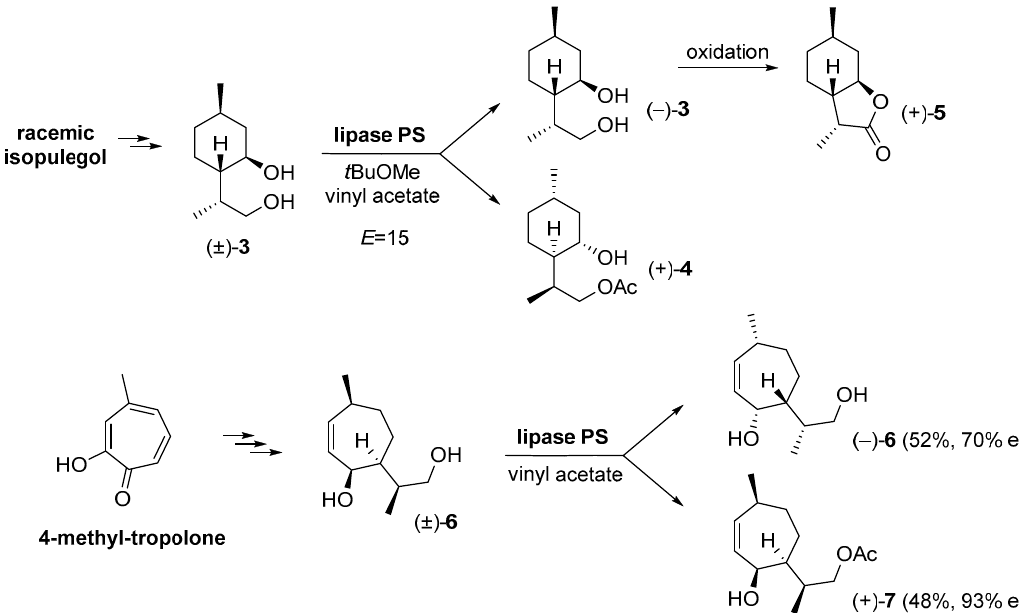
Figure 2. The lipase-PS-mediated resolution of the diastereoisomerically pure racemic diols ( 3 ) and ( 6 ).